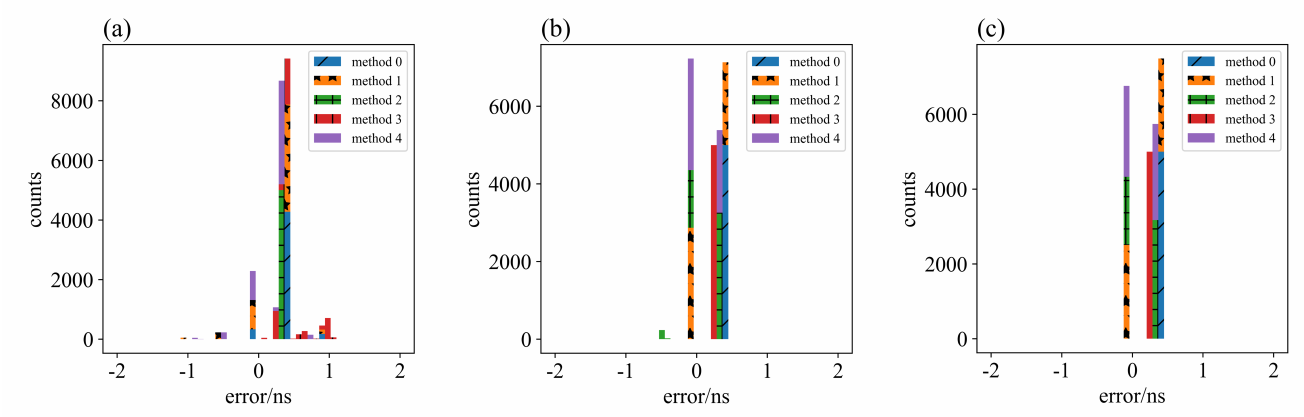
Figure 6. The histogram of ranging error distribution: ( a ) the ranging error distribution of each method in test.1; ( b ) the ranging error distribution of each method in test.2; ( c ) the ranging error distribution of each method in